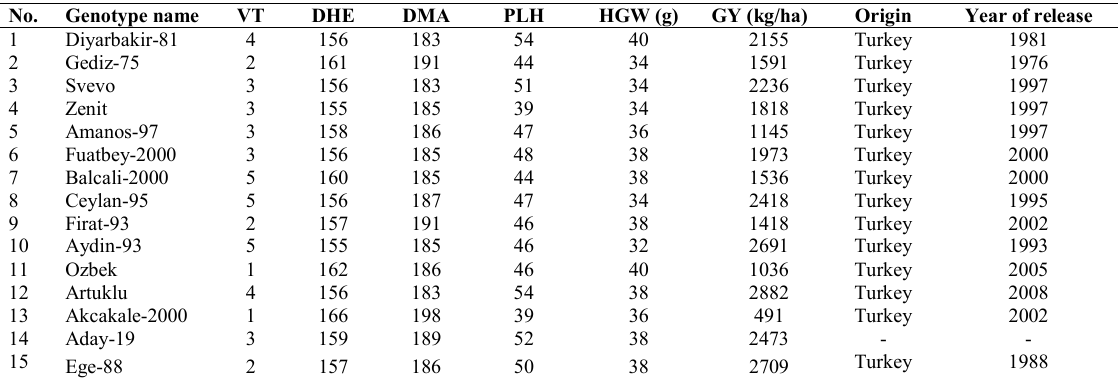
Table 1. List of spring durum wheat genotypes used in the experiment. No. Genotype name